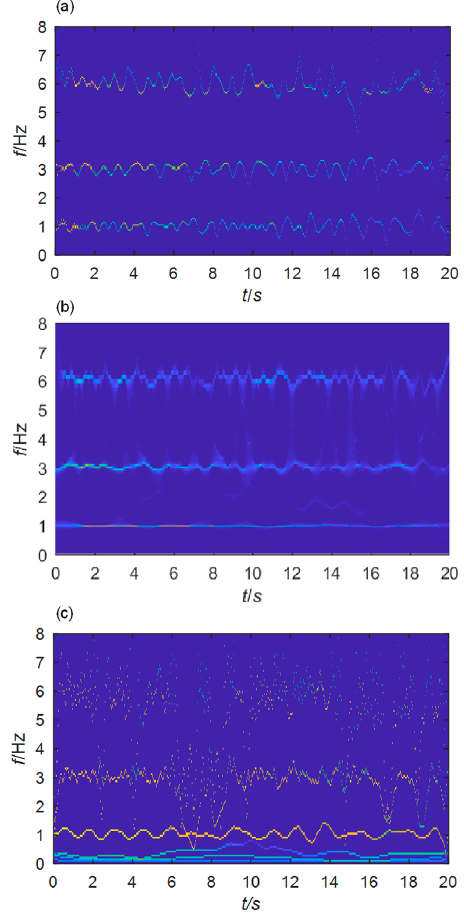
Figure 4. TF planes of mono-components extracted from the simulated signal by: ( a ) EWT; ( b ) SWT; ( c ) HHT.